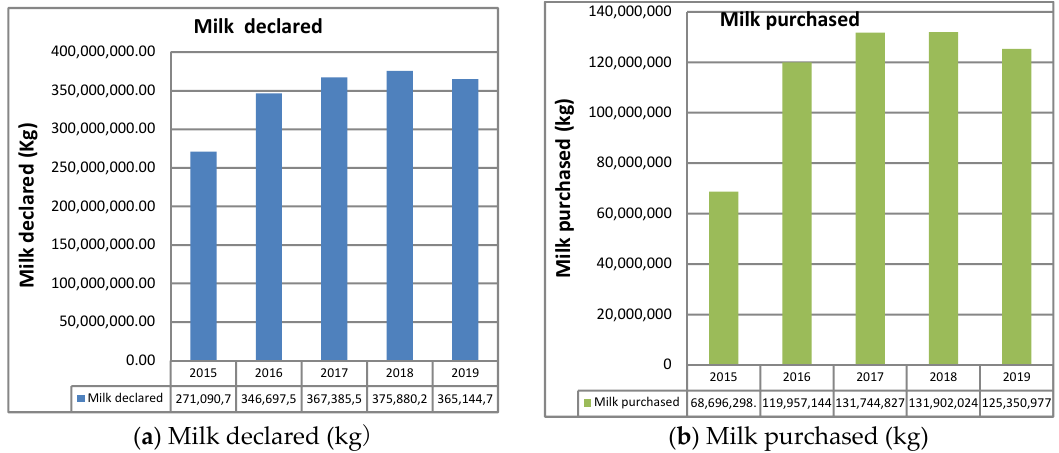
Figure 7. Milk product registrants ( a ) and milk purchased for non-PDO dairy products ( b ).